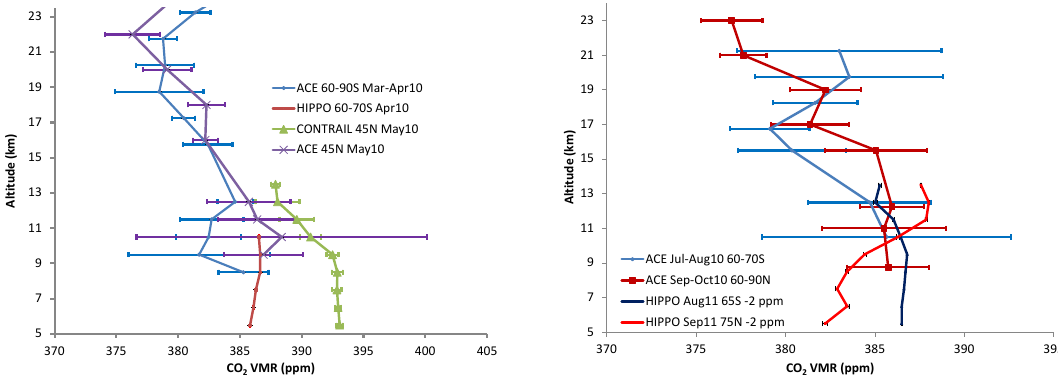
Figure 15. On the left – latitudinal gradient in CO 2 VMR observed in boreal spring using satellite-based observations (ACE-FTS) and in in situ data (HIPPO and CONTRAIL). All measurements are from the year 2010. The 45 ◦ N band comprises measurements from 30–60 ◦ N for both ACE-FTS and CONTRAIL. Medians are shown for ACE-FTS to reduce sensitivity to outliers while averages are shown for HIPPO and the error bars are the standard errors for both instruments. For CONTRAIL, we plot the average three sub-bands (30–40, 40–50, and 50–60 ◦ N), and each error bar represents the standard error of the three sub-band averages at that altitude. ACE-FTS data points between 13.0 and 15.0km are excluded due to aerosol extinction (affects THs). Vertical bins of 1.5 and 2km are used above 15.0km to improve samples sizes per bin, particularly above 19.0km for the ACE-FTS profiles of March to April 60–90 ◦ S and May 45 ◦ N, respectively. On the right – same as left panel but for boreal summer. HIPPO measurements are from the year 2011, so we subtract 2ppm to account for the annual